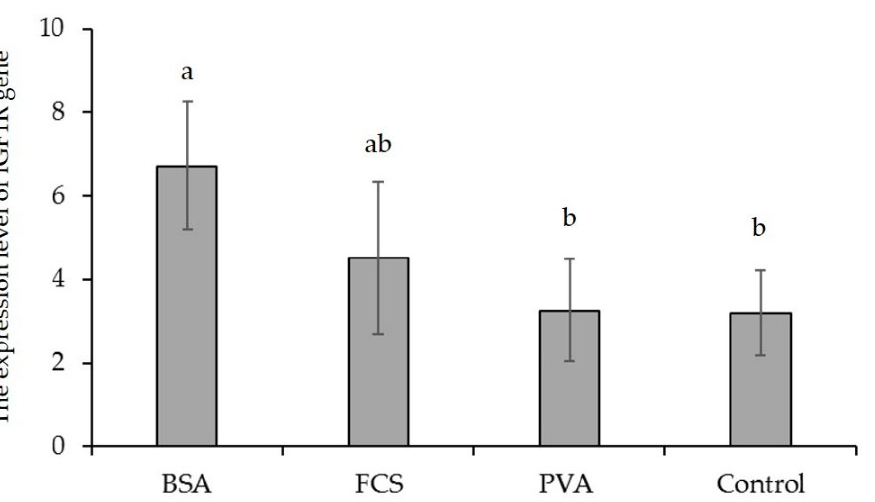
Figure 4. The expression levels of the IGF1R gene in bovine oocytes matured in media supplemented with different macromolecules. BSA = bovine serum albumin, FCS = fetal calf serum, PVA = polyvinyl alcohol. The error bars represent the standard error of means, and bars with different letters are significantly different at p < 0.05.